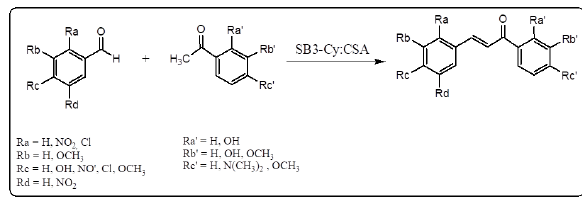
Figure 11: Claisen-Schmidt reaction of acetophenones and mono- and bi- substituted benzaldehydes catalyzed by DES. g